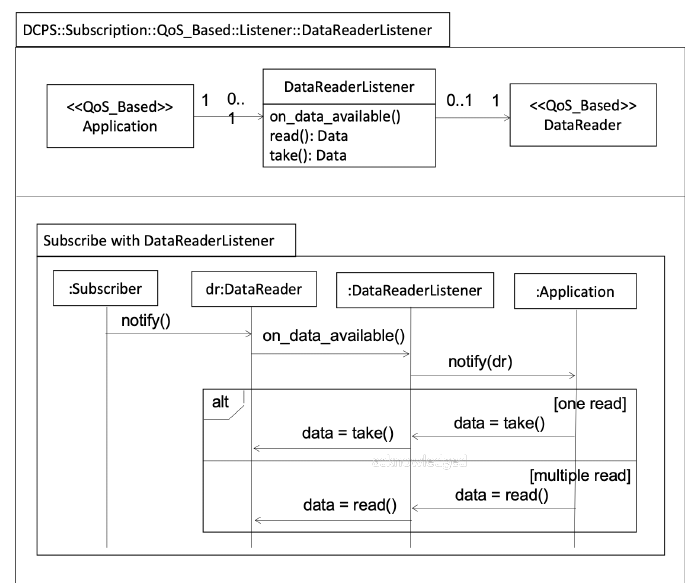
Figure 18. DataReaderListener